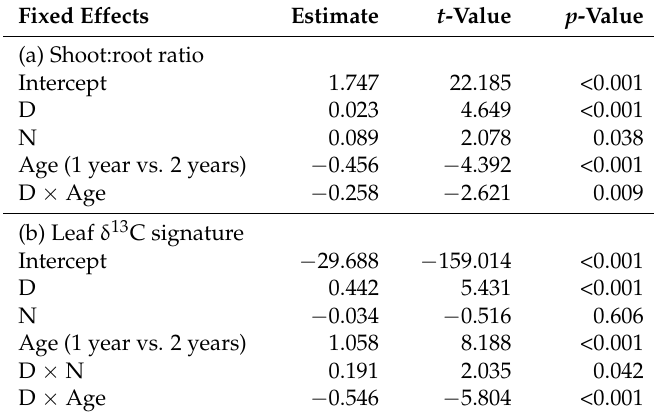
Table 2. Best-fitting mixed-effects models for (a) shoot:root ratio and (b) leaf δ 13 C signatures of Fagus sylvatica saplings. Shoot:root ratios and leaf δ 13 C signatures were modelled as a function of the saplings’ age (one-year old vs. two-year-old plants), drought treatments (D, ND), nitrogen treatments (N, ND), and their interactions. The best-fitting model was selected using the Akaike information criterion